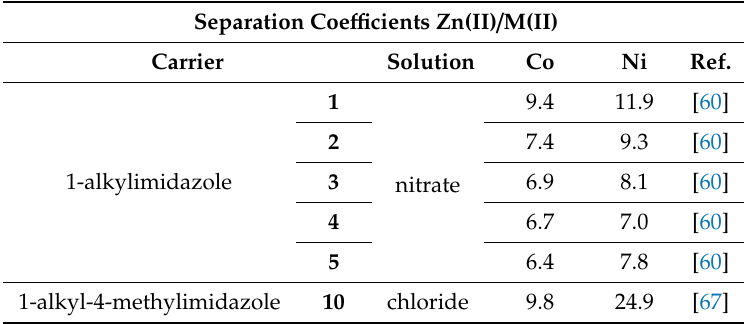
Table 11. Zinc(II) separation coe ffi cients from 3-component Zn–Co–Ni equimolar solutions after a 24-h transport across PIMs doped with